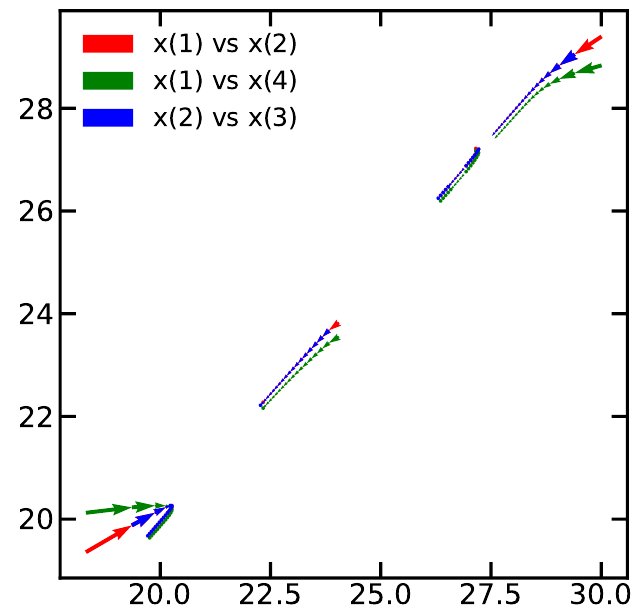
Figure 13. Phase diagram during fault in actuator.